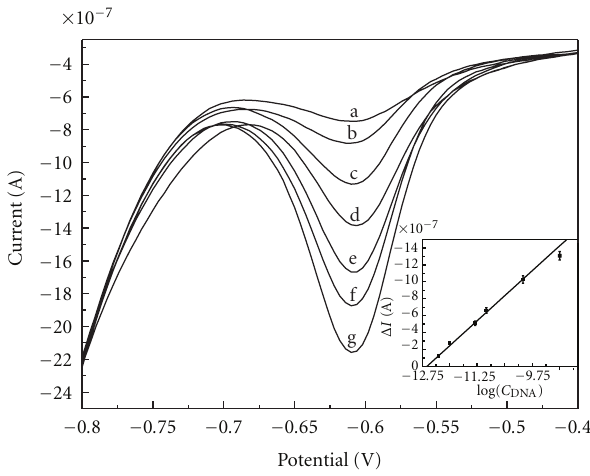
Figure 5: The histograms of the peak current di ff erence ( Δ I ) of adriamycin versus di ff erent DNA sequences (1.0 × 10 − 10 M): (A) noncomplementary sequence, (B) single-base mismatch sequence, (C) complementary sequence. Inset: DPV responses of adriamycin recorded at probe modified electrode (a) and after hybridization with 1.0 × 10 − 10 M noncomplementary sequence (b); 1.0 × 10 − 10 M single-base mismatch sequence (c); 1.0 × 10 − 10 M complementary sequence (d). Accumulationtime of adriamycin: 20min; Hybridiza- tion time: 25 min. DPV parameters were the same as in Figure 2(B). respectively. The average value was 1 . 2402 × 10 − 6 A, and the relative standard deviation (RSD) was 2.15%.